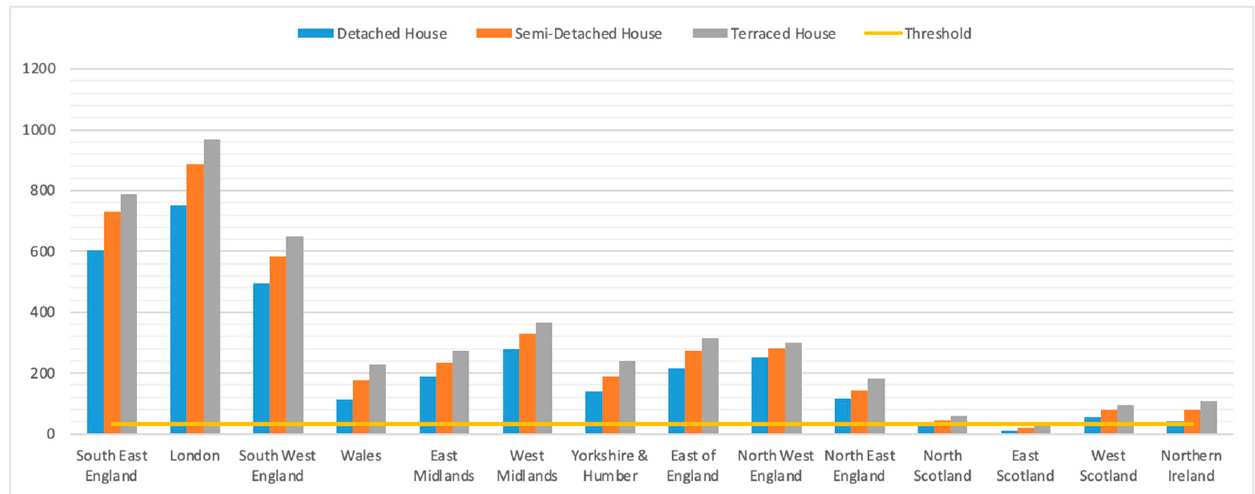
Figure 6. Base model annual bedroom overheating with PROMETHEUS 2030s, high-emissions cli- mate data; line shows 32 h overheating threshold.